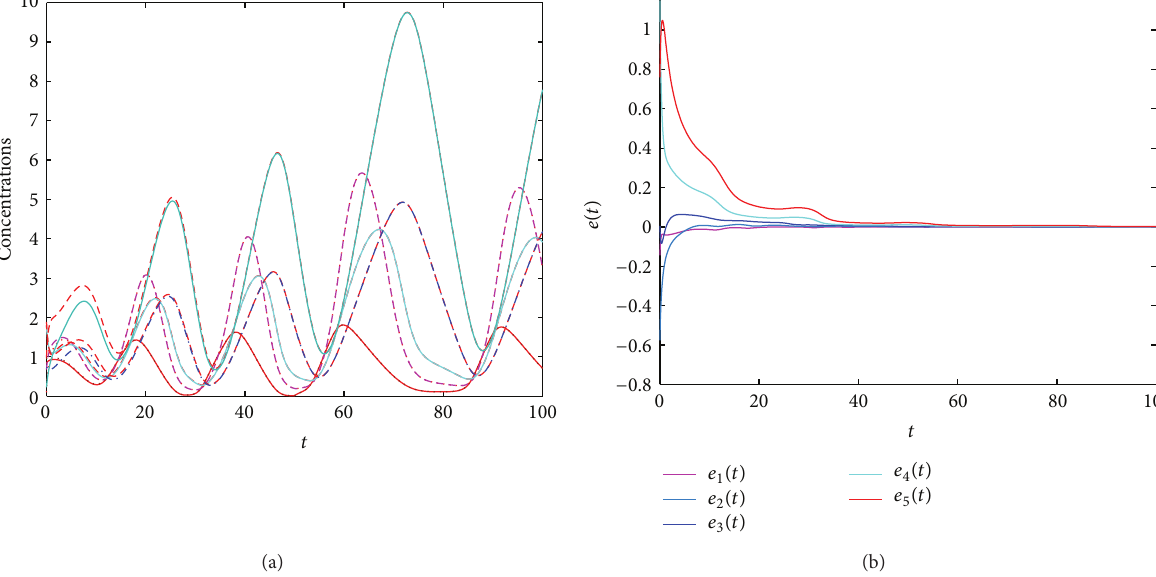
Obviously, the corresponding observer (17) is more complex than the observer